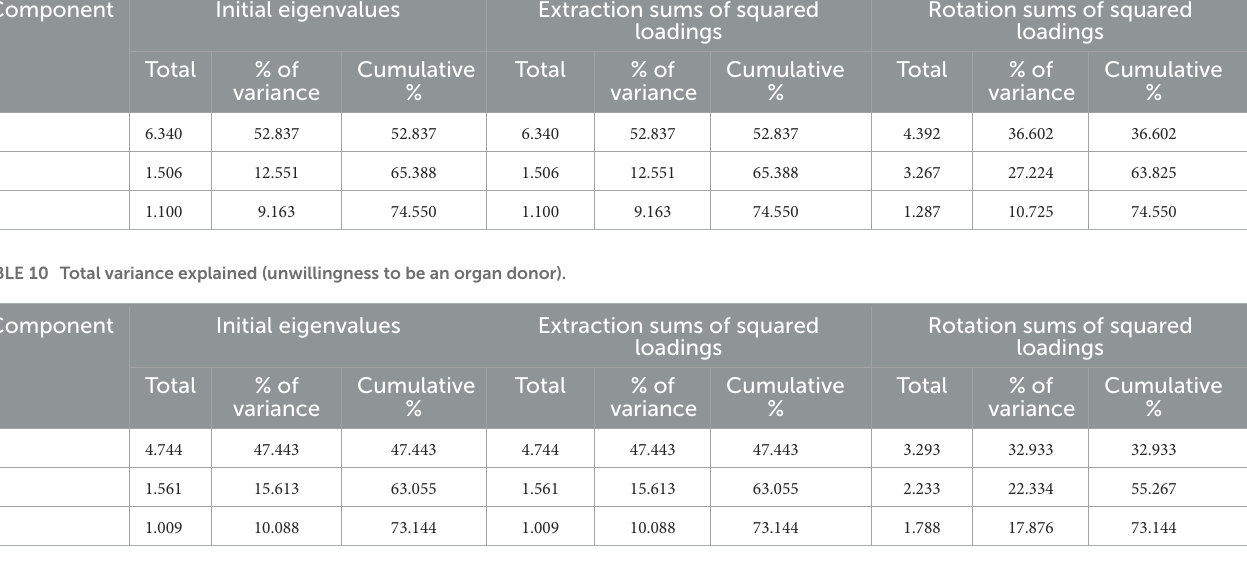
TABLE 9 Total variance explained (willingness to be an organ donor). Component